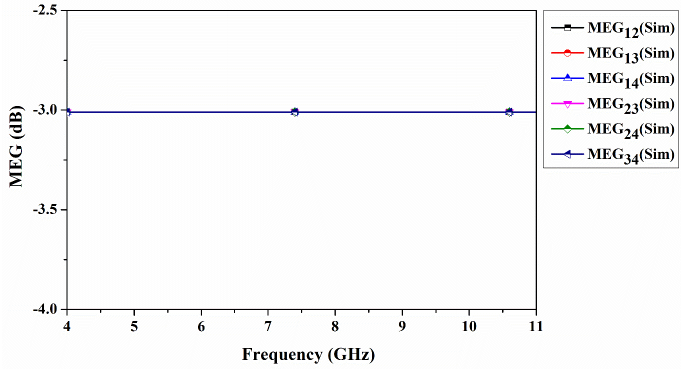
Figure 13. Mean effective gain of quad-port antenna. Table 7. Comparison of MIMO antenna from the reported literature.